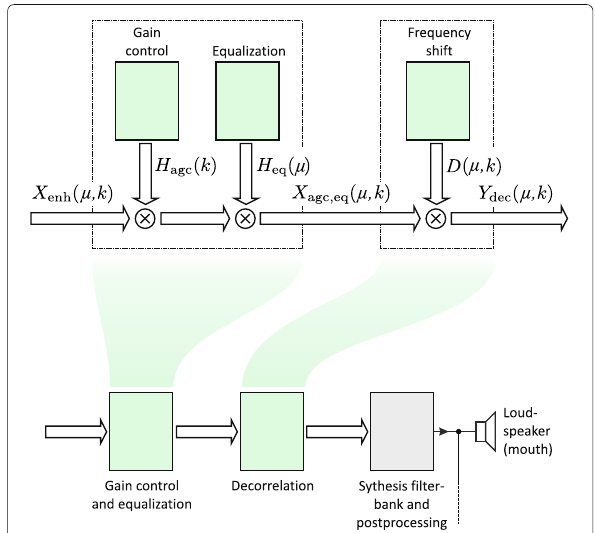
Fig. 12 Structure of the gain control and equalization as well as of the decorrelation